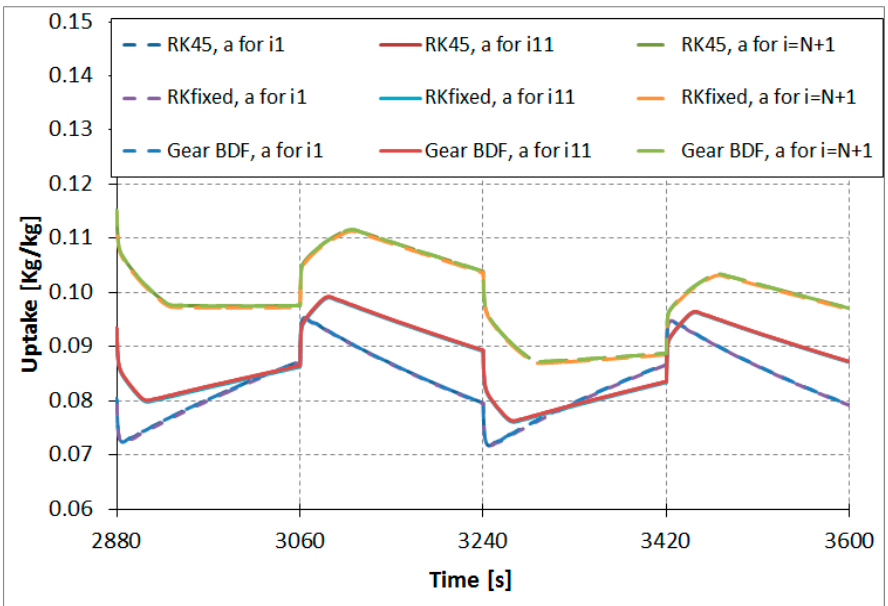
Figure 6. Results comparison of RKfixed, RK45, and Gear BDF methods, calculated uptake a in nodes i = 1, i = 11, and i = 21 ( N = 20).